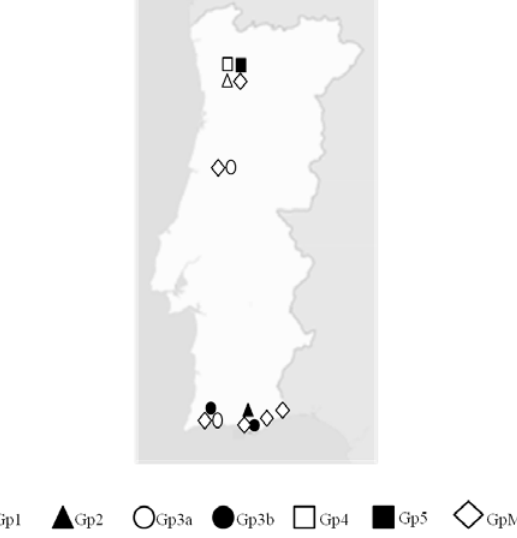
Figure 4. Outline map of Portugal showing the distribution of phylogenetic variants of CTV in the period